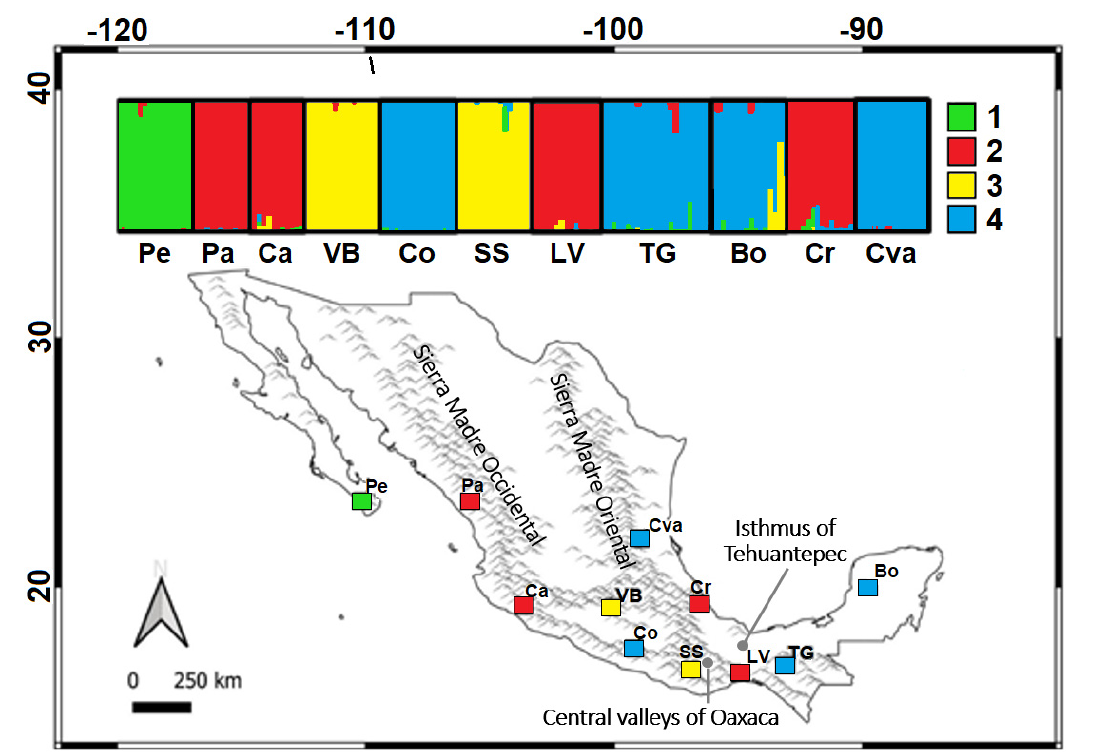
Figure 5. Results of the STRUCTURE analysis for Natalus mexicanus individuals. Assignment of individuals to genetic groups in K = 4. Acronyms are as follows (locality, federal entity): Pe—Pescadero, B.C.S.; Pa—P á nuco, Sin.; Ca—Cardona, Col.; VB—Valle de Bravo, E. Mex.; Co—Colotipla, Gro.; SS—San Sebasti á n, Oax.; LV—La Venta, Oax.; TG—Tuxtla Guti é rrez, Q. Roo; Bo—Bolonch é n, Cam.; Cr—Carrizal. Ver.; Cva—Ciudad Valles, S.L.P. Major geographic barriers are indicated.